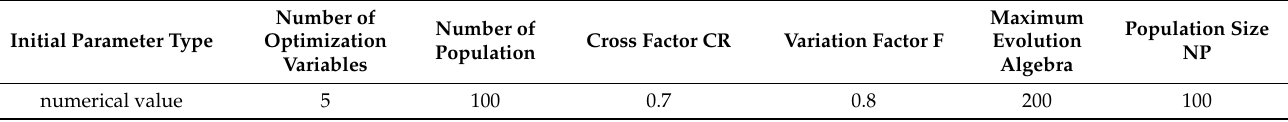
Table 6. Initial parameters of differential evolution.